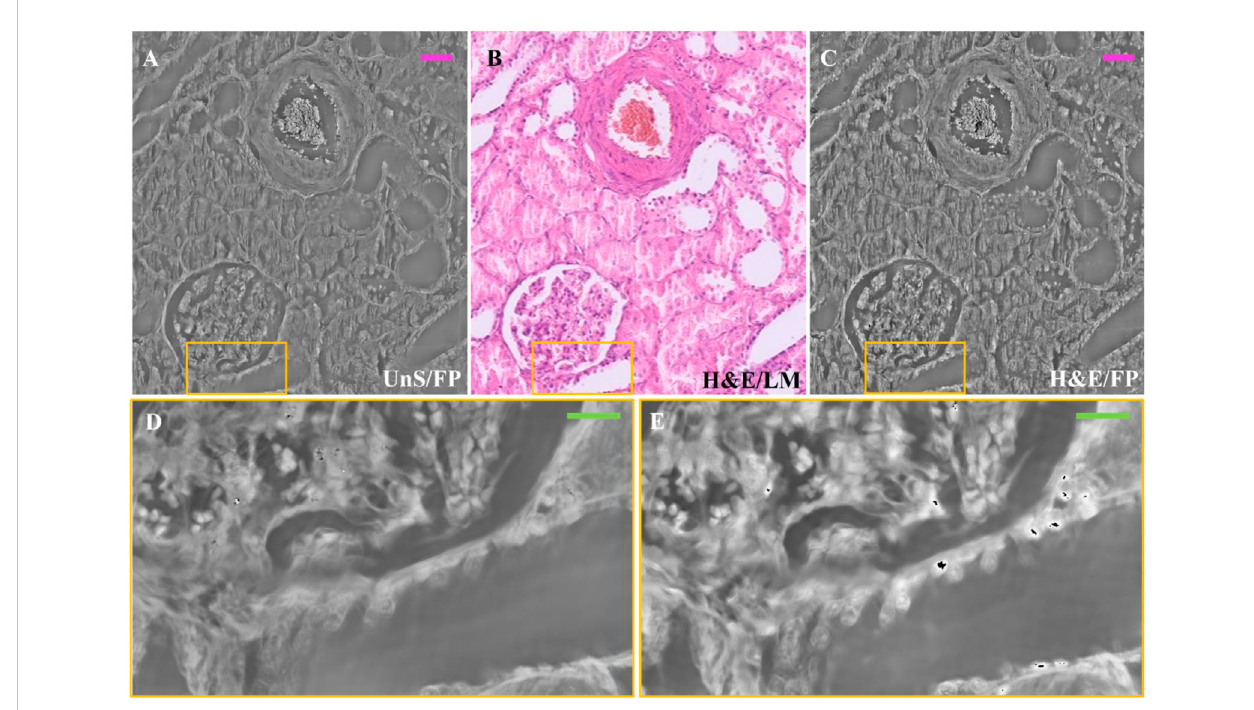
FIGURE 4 Unstained andH&E-stained images comparison: (A) Unstained renaltissue portioncapturedbyFP; (B) H&E-stained renal tissue portioncapturedby LM as gold standard; (C) H&E-stained renal tissue portion captured by FP. The scale bar is ~50 μ m; (D) zoomed area of the unstained renal tissue of the yellow box in (A – E) zoomed area of the H&E-stained renal tissue of the yellow box in (C) . The green bar is ~17.5